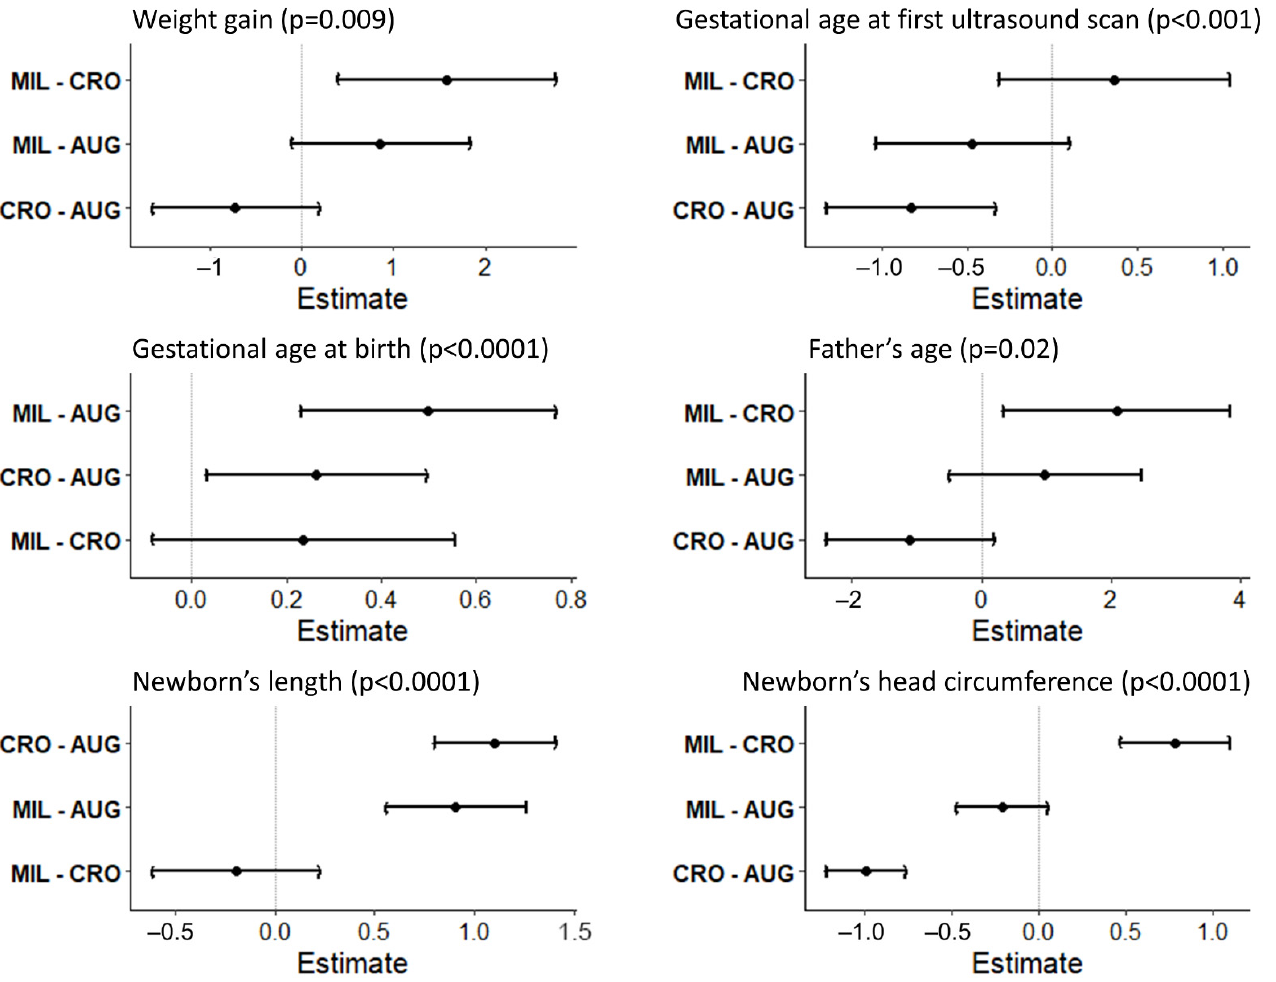
Figure 2. Tukey’s post hoc multiple comparisons among the three national priority contaminated sites (NPCSs). Six variables relevant to gestational period and birth outcomes are evaluated. MIL: Milazzo NPCS; AUG: Augusta-Priolo NPCS; CRO: Crotone NPCS.